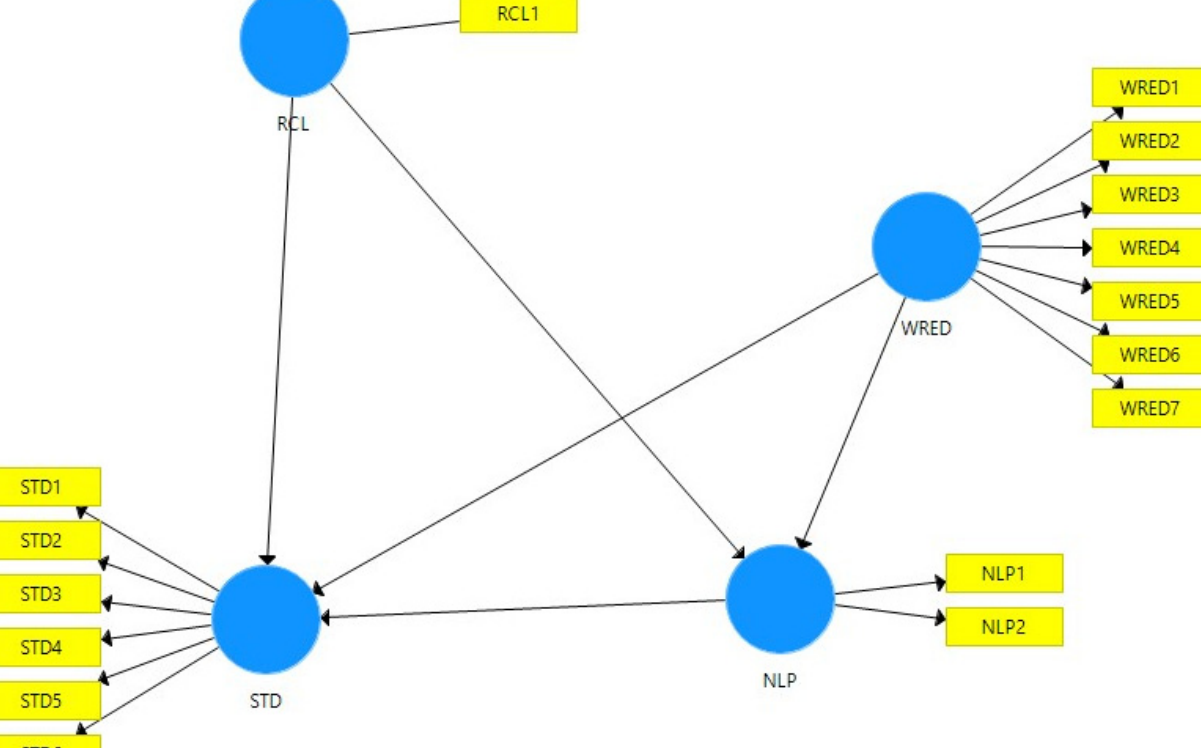
Figure 1. The research model. Source: Created using SmartPLS.